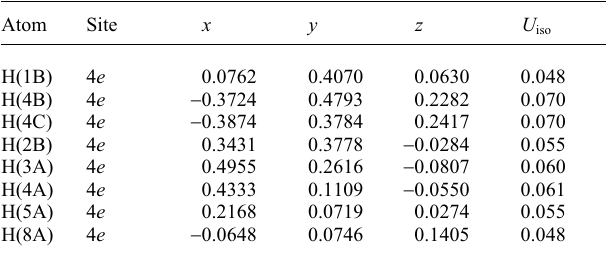
Table 2. Atomic coordinates and displacement parameters (in Å 2 )